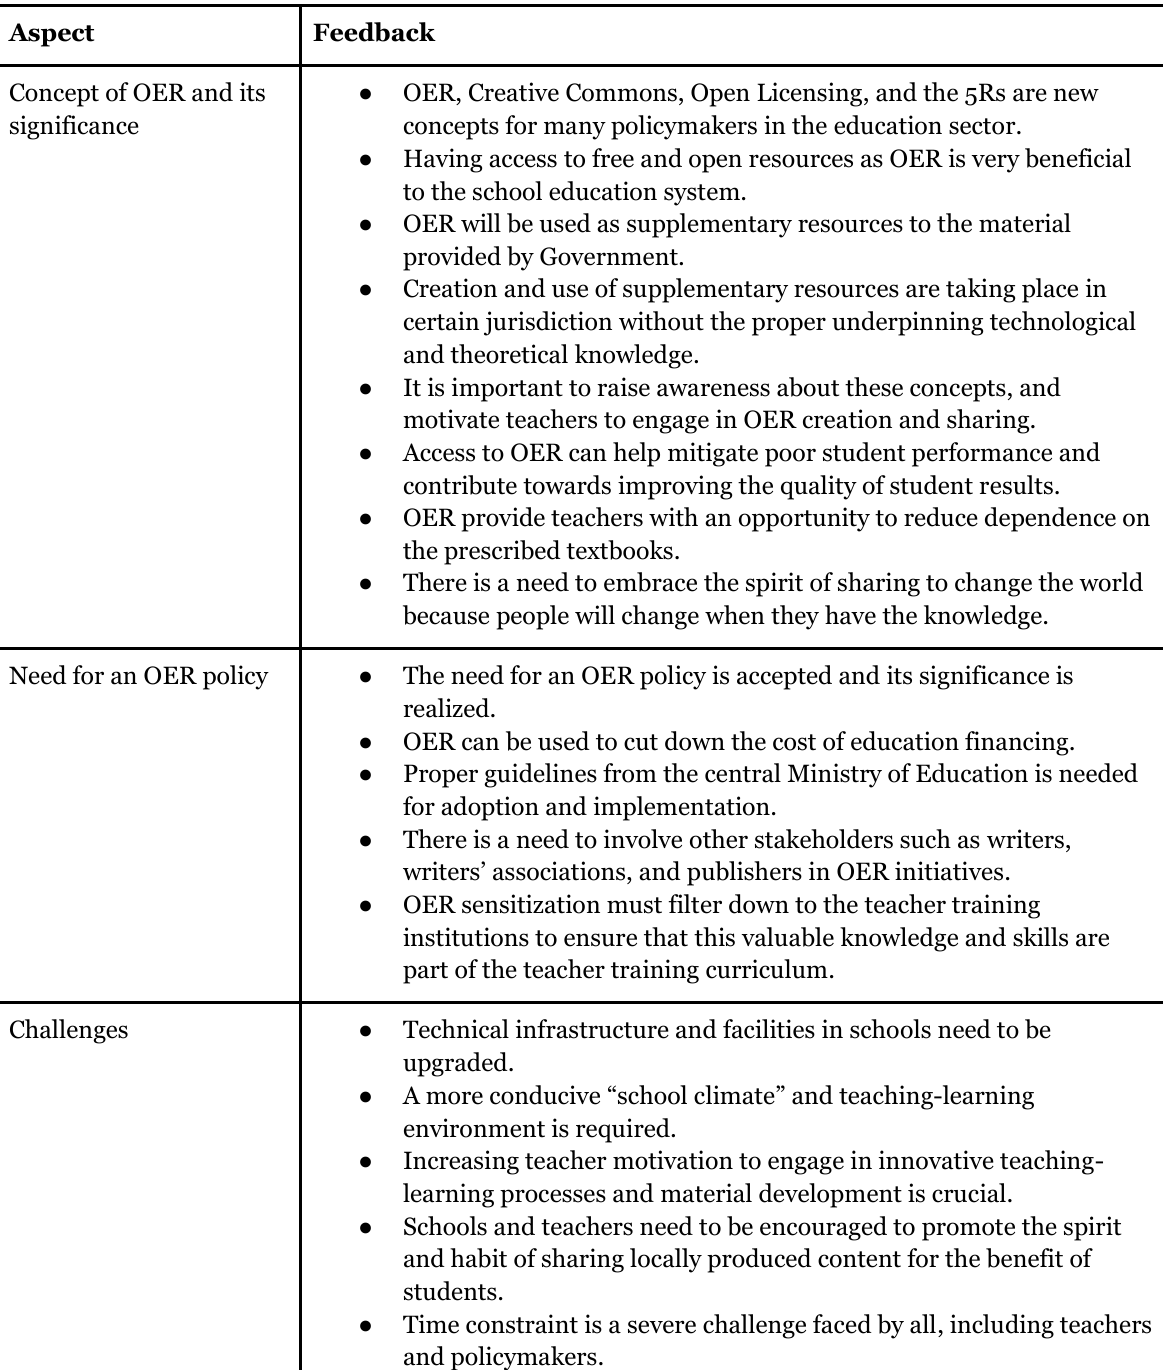
Table 2 Key Takeaways From the Project Based on Participant Feedback Aspect Feedback Concept of OER and its